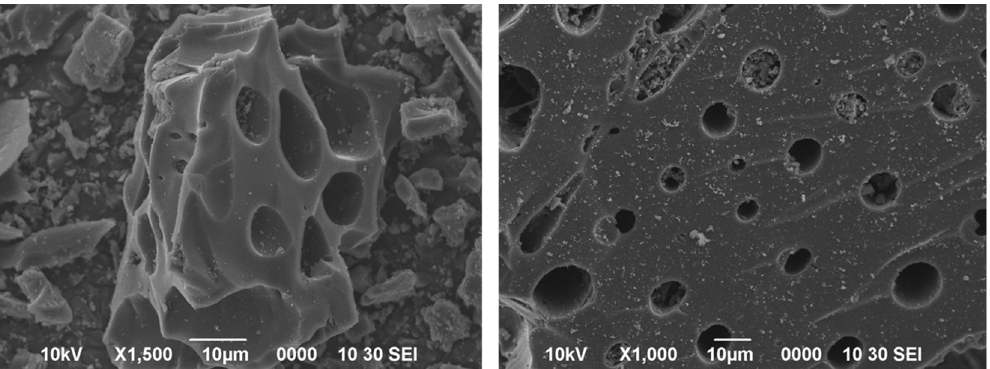
Figure 3. Scanning electron micrographs of sago bark ash at 1500× and 1000× magnifications.